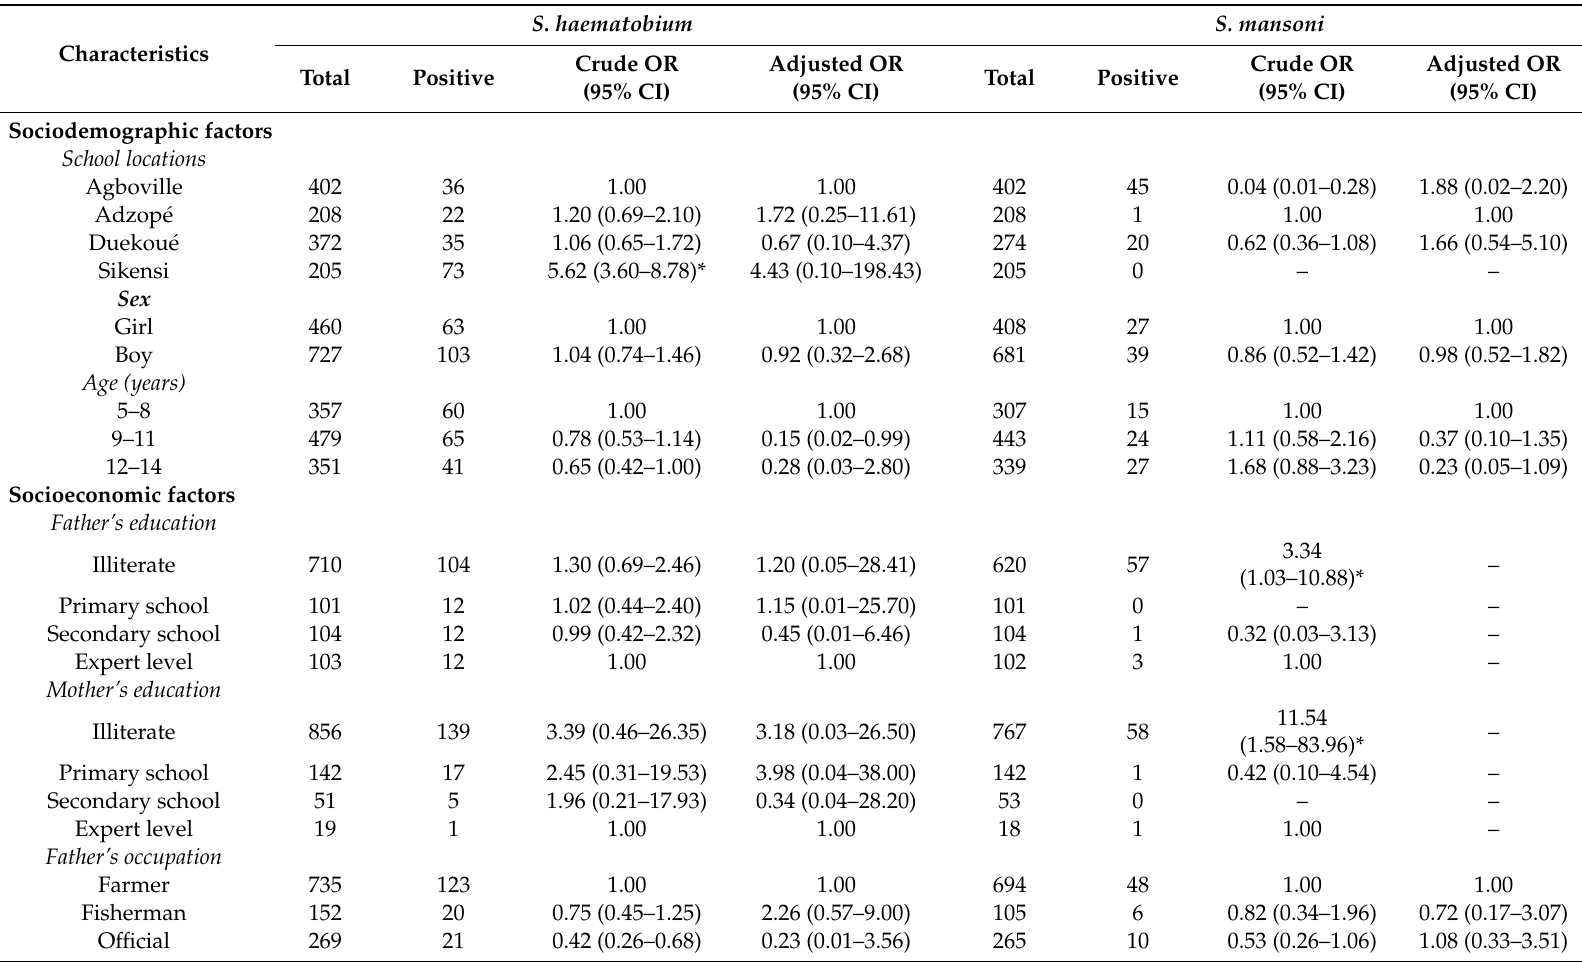
Table 3. Multivariate logistic regression model analysis of variables associated with S. haematobium and S. mansoni infection among schoolchildren non-adjusted and adjusted for sociodemographic factors, socioeconomic status, and environmental